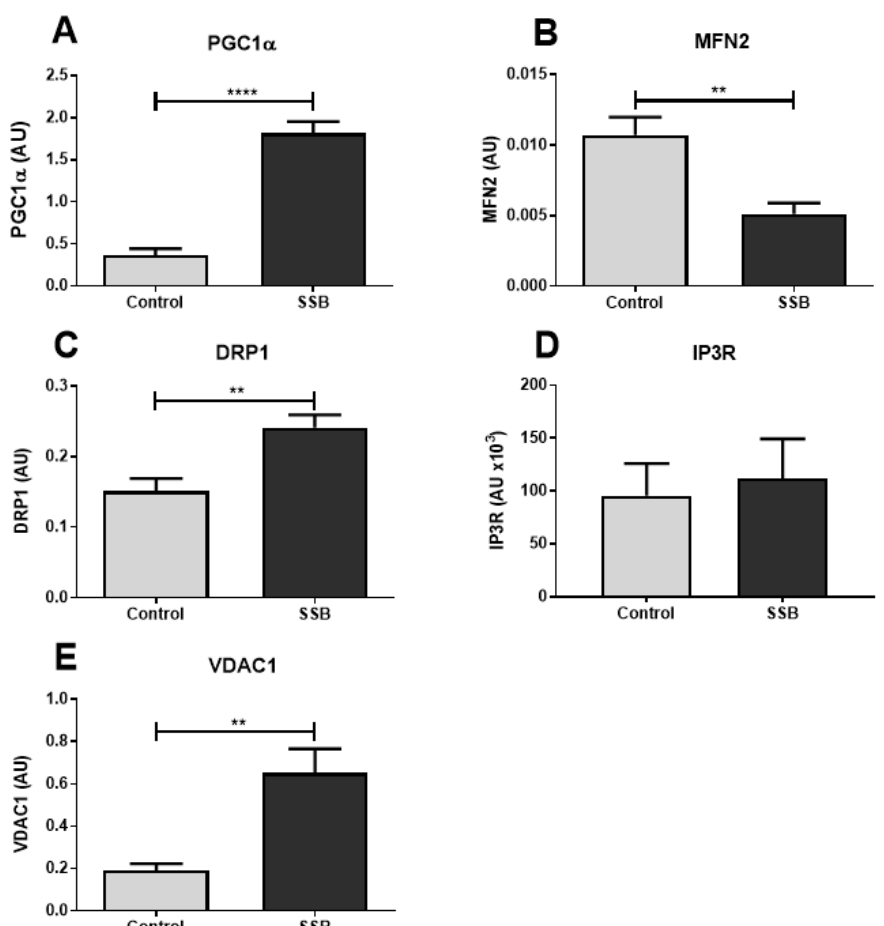
Figure 2. The impact of SSB consumption on mitochondrial markers. ( A ) Peroxisome proliferator- activated receptor gamma coactivator 1-alpha (PGC1), ( B ) mitofusin 2 (MFN2), ( C ) dynamin-related protein 1 (DRP1), ( D ) inositol-1,4,5-triphosphate receptor (IP3R), and ( E ) voltage-dependent anion-selective channel 1 (VDAC1). Data are displayed as mean ± SEM. ** p < 0.01; **** p < 0.001 ( n = 8).